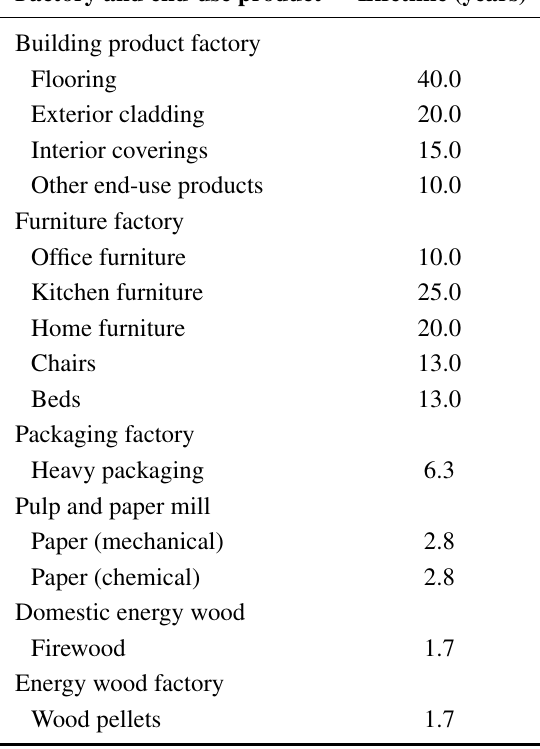
Table 1. Average lifetimes of the different end-use products (adapted from Fortin et al .